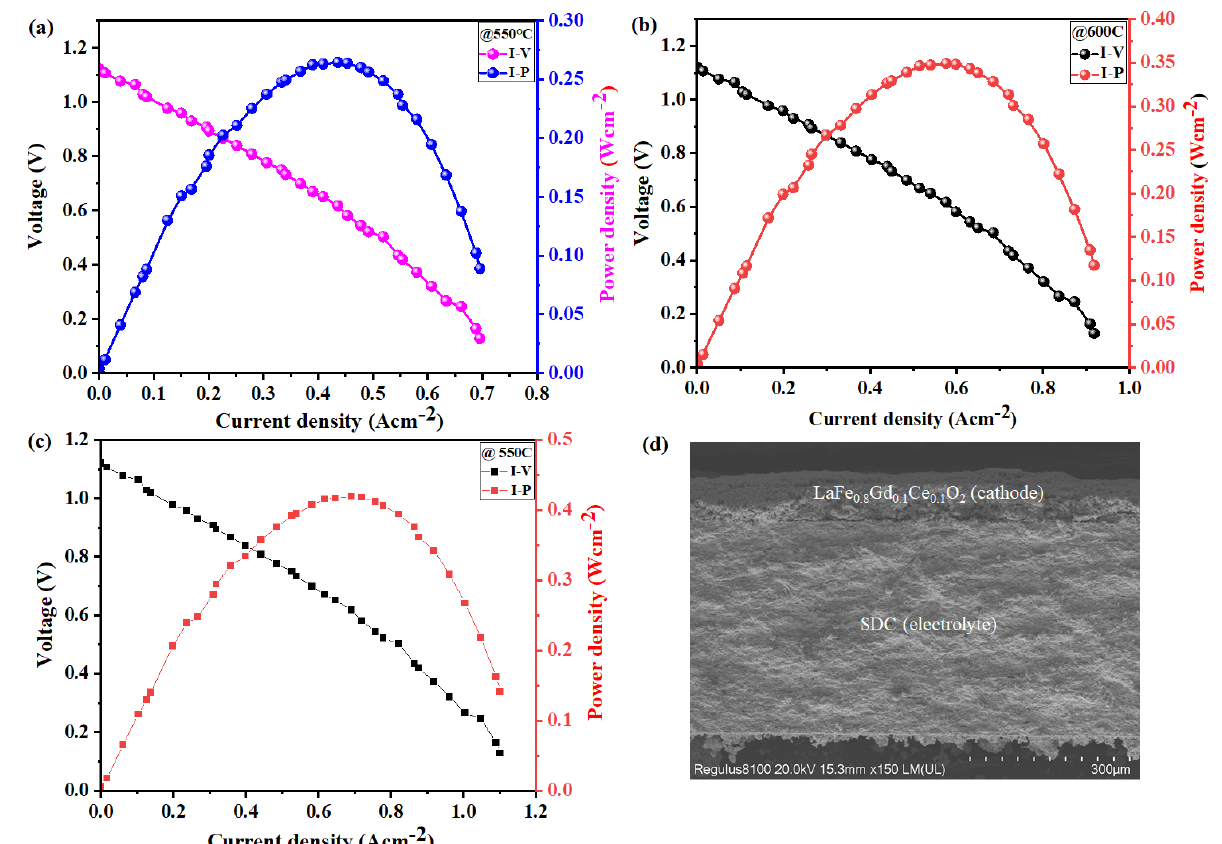
Figure 5. ( a − c ) Electrochemical performances: characteristic curves of utilizing our LaFe 0.8 Gd 0.1 Ce 0.1 O 3- δ when comparing LaFeO 3 and LaFe 0.9 Gd 0.05 Ce 0.05 O 3- δ cathodes in fuel cells over SDC electrolyte and NCAL-Ni-foam anode operated at 550 °C ( d ) cross-sectional SEM images of tri-layer electrolyte supported fuel cell along with prepared LaFe 0.8 Gd 0.1 Ce 0.1 O 3- δ cathode and SDC electrolyte examined after the electrochemical test.